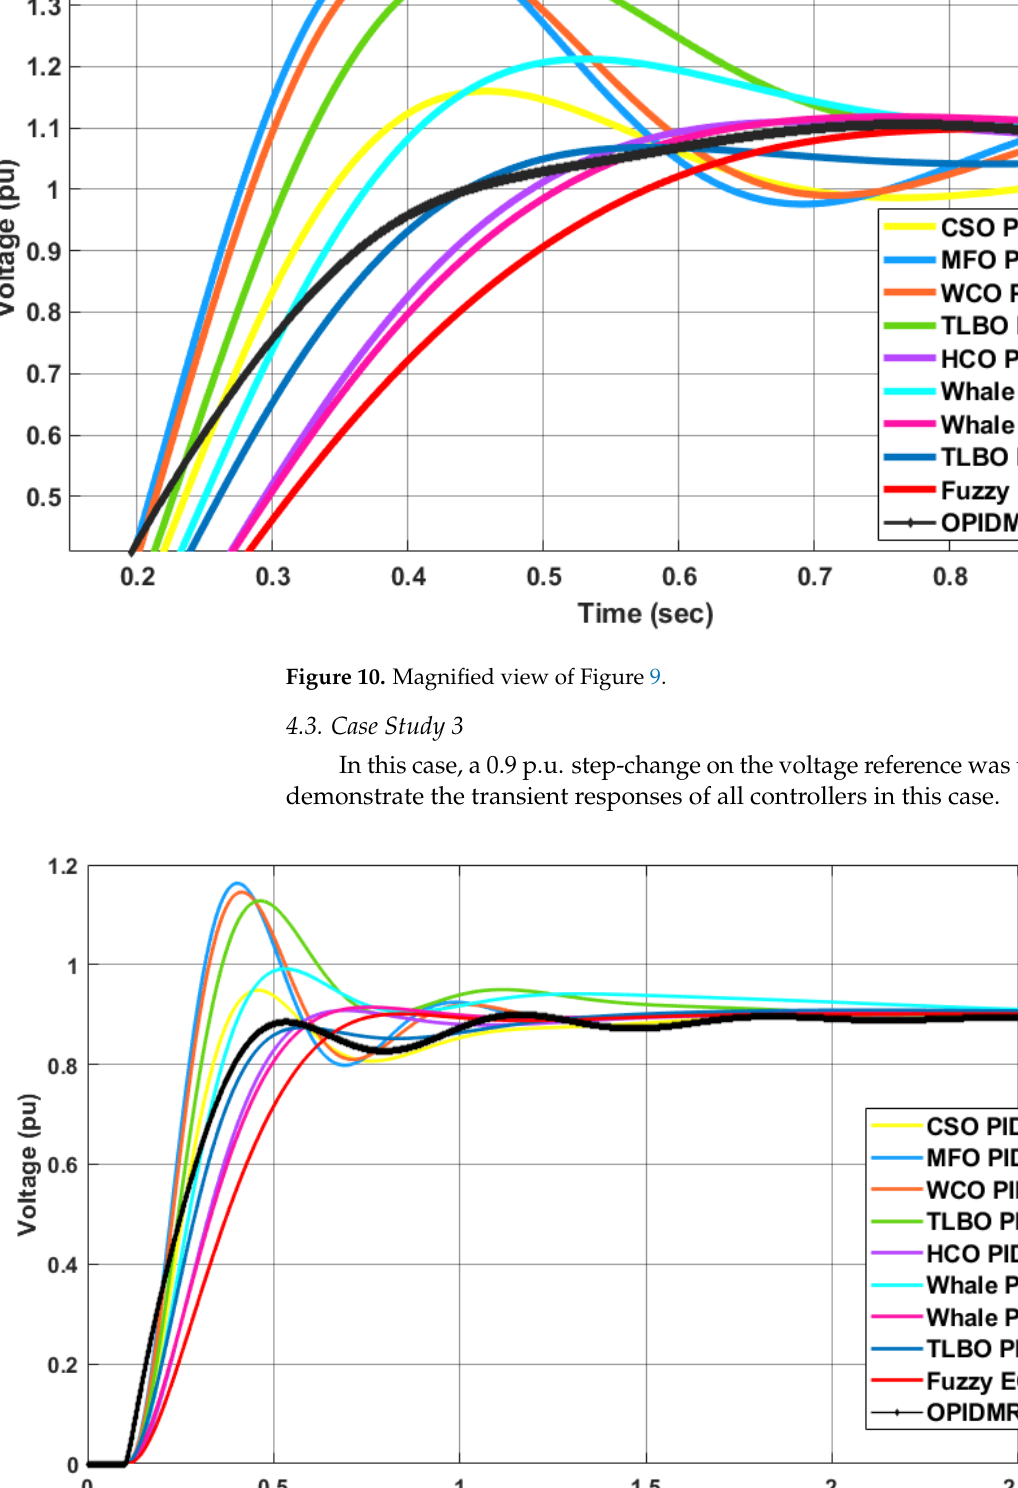
Figure 9. Step-change of 1.1 p.u. on the voltage reference of the AVR model.